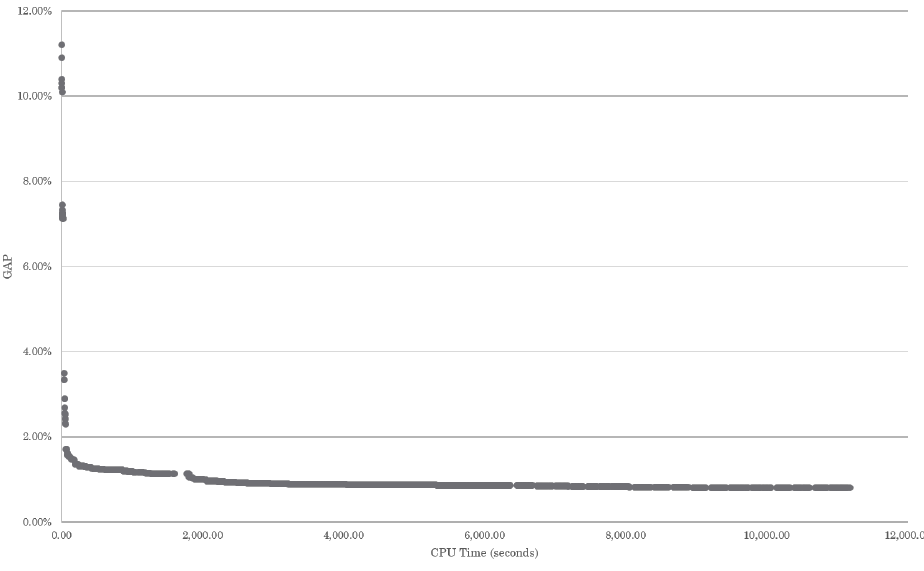
Figure 1. GAP analysis for the test instance